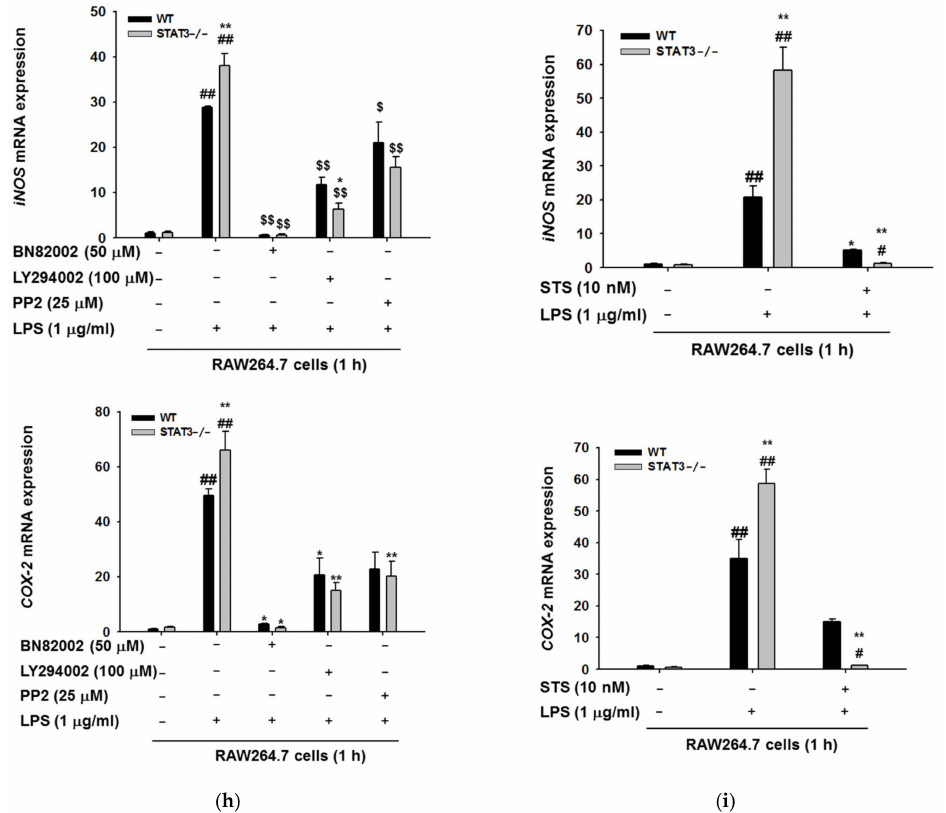
Figure2. EarlyeffectsofLPSon iNOS and COX-2 andNF- κ B-dependentinflammatorysignalingpathways in WT and STAT3KO macrophages. ( a ) The mRNA expression of iNOS , COX-2 , and their protein levels were measured after 60 min incubation with LPS as assessed by qRT-PCR and immunoblotting blotting analyses. Values represent average concentrations of the indicated cytokines. ( b ) Wild type and STAT3 - / - RAW264.7 cells were incubated with LPS (1 µ g / mL for 0–60 min) and the nuclear fractions of p50 and p65 were examined using immunoblotting blotting analyses with lamin A / C used as an internal control. ( c ) Wild type and STAT3 - / - RAW264.7 cells were stimulated with 1 µ g / mL LPS for the indicated period of time. Whole-cell lysates were then subjected to immunoblotting to identify phosphorylation and total forms of inhibitor of kappa B (I κ B α ,), I κ B α kinase α / β (IKK α / β ), and protein kinase B (Akt), with β -actin as an internal control. ( d ) Immunoblotting was performed in wild type and STAT3 - / - RAW264.7 cells were left untreated or incubated with LPS for the indicated period. Phosphorylated and total forms of Lyn, Syk, Src, and p85 were examined. β -actin was used as the internal control. ( e ) The MAPK signaling pathway activation (as represented by ERK, p38, and JNK) was also assessed after LPS (1 µ g / mL) stimulation in wild type and STAT3 - / - RAW264.7 macrophages, using β -actin as an internal control. ( f ) WT and STAT3KO cells were treated with BAY11-7082 (15 µ M) for 30 min prior to LPS (1 µ g / mL) treatment for 5–60 min. Whole cell proteins were isolated and immunoblotted with indicated antibodies to p-p65 and p-p50. ( g ) WT and STAT3KO cells were treated with BAY11-7082 (15 µ M) for 30 min prior to LPS (1 mg / mL) treatment for 6 h. Isolation of RNA, generation of cDNA, and quantitative RT-PCR were performed for iNOS determination. ( h , i ) RAW264.7 and STAT3KO macrophages were pre-treated with or without 50 µ M of BN82002, 100 µ M of LY294002, 25 µ M of PP2, or 10 nM of staurosporine (STS) for 30 min, followed by LPS (1 µ g / mL) stimulation. qRT-PCR was used to evaluate iNOS (upper panels) and COX-2 (lower panels) mRNA gene expression. Data represent mean ± SD, replicates of three independent experiments. Relative intensity is defined as the intensity of the target protein normalized to β -actin. Values are presented as the mean ± standard deviation. ## p < 0.01 compared to normal group in the same cell type, $ p < 0.05 and $$ p < 0.01 compared to LPS alone, and * p < 0.05 and ** p < 0.01 compared to the same condition of wild type. NF: nuclear fractions. WCL: whole cell